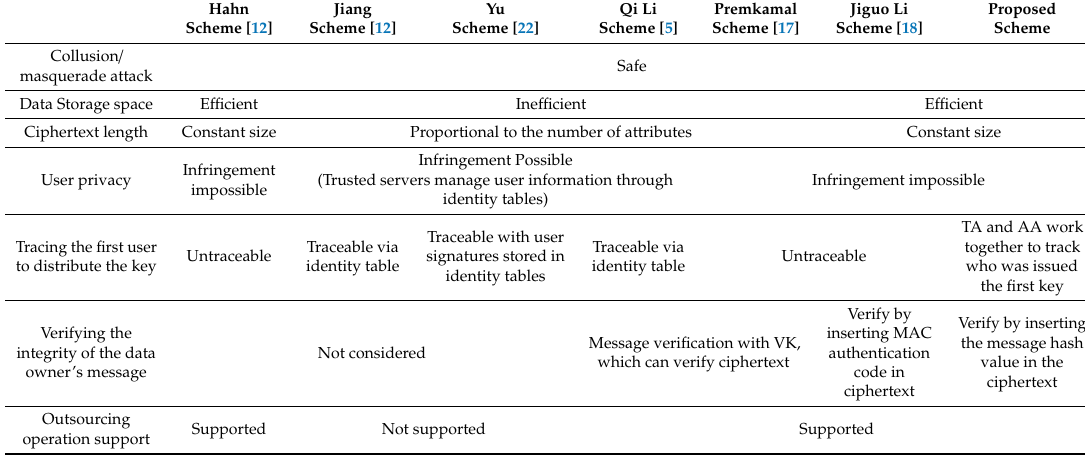
Table 3. Comparison of security requirements of this proposed scheme and the existing CP-ABE.